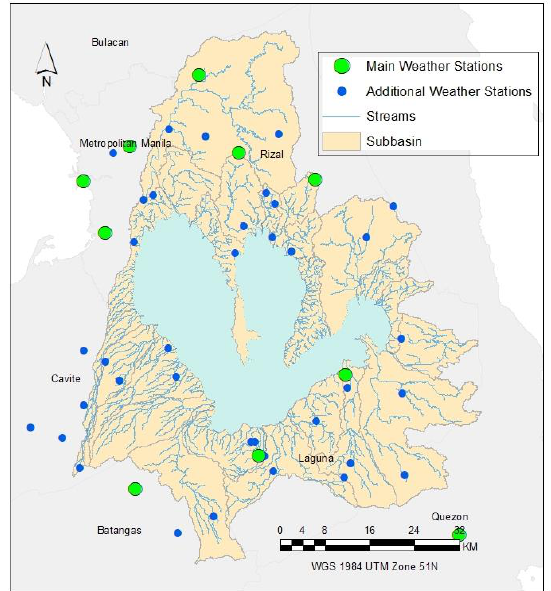
Figure 5 . Weather stations used in the SWAT models. Ten local monitoring stations (green circles) with a period of 1995 to 2019 were processed using Weather Generator (WGN) for the SWAT Database. These continuous long-term datasets served as the main stations and were used to generate values for the missing data from the additional weather stations (blue circles) with monitoring periods ranging from 2011 to